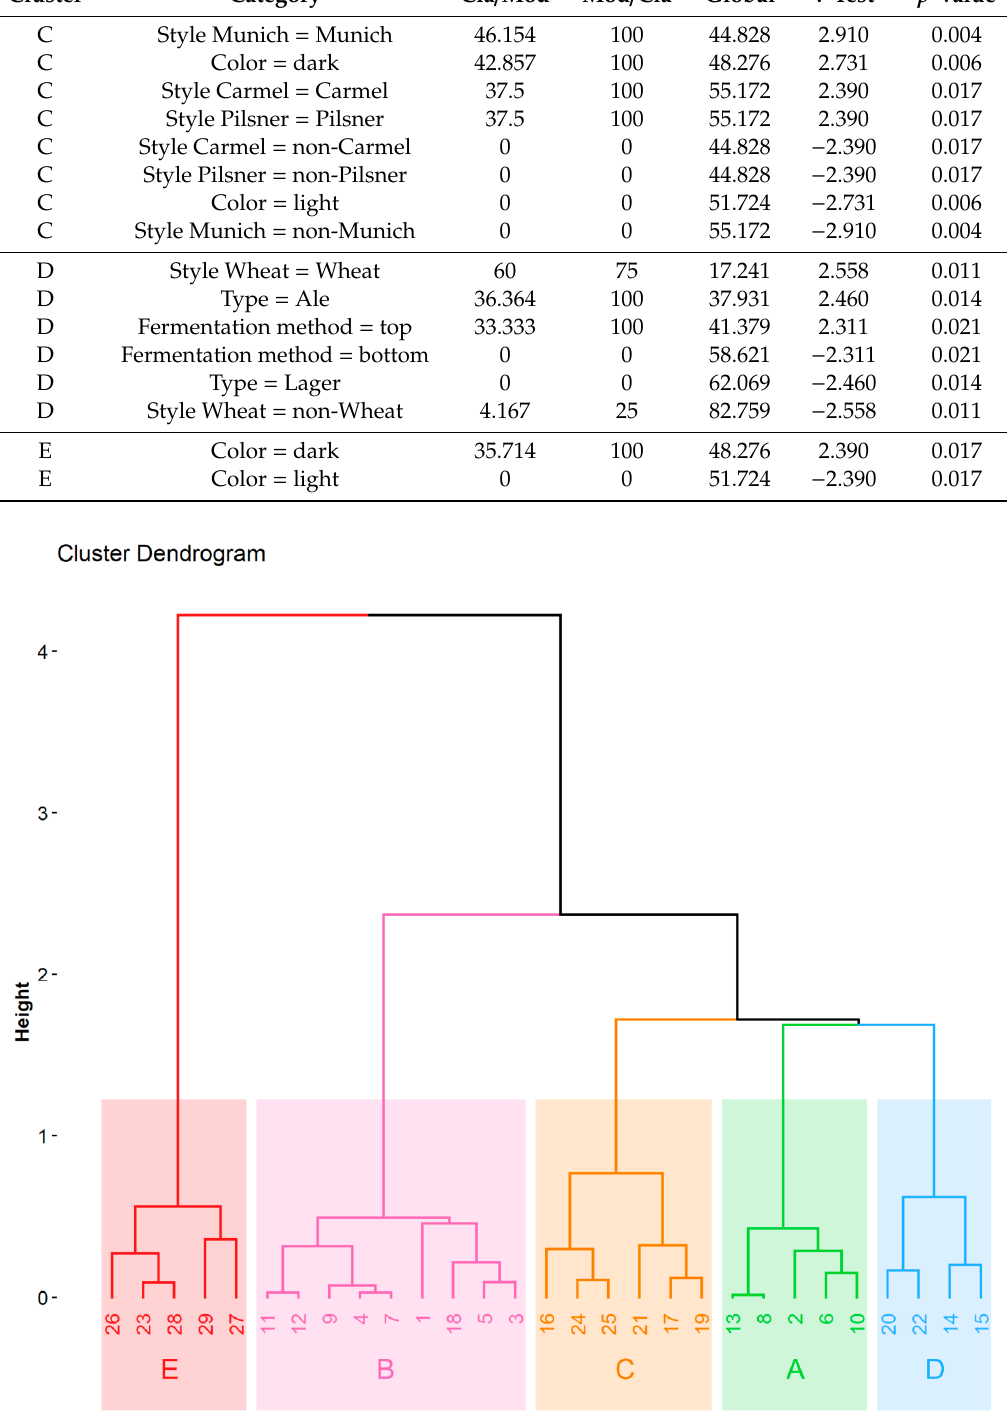
Figure 3. Dendrogram from hierarchical clustering on principal components, created using 6 dimensions (78.3% of explained variance) from the factor analysis of mixed data (FAMD) model and showing the clustering of beers.